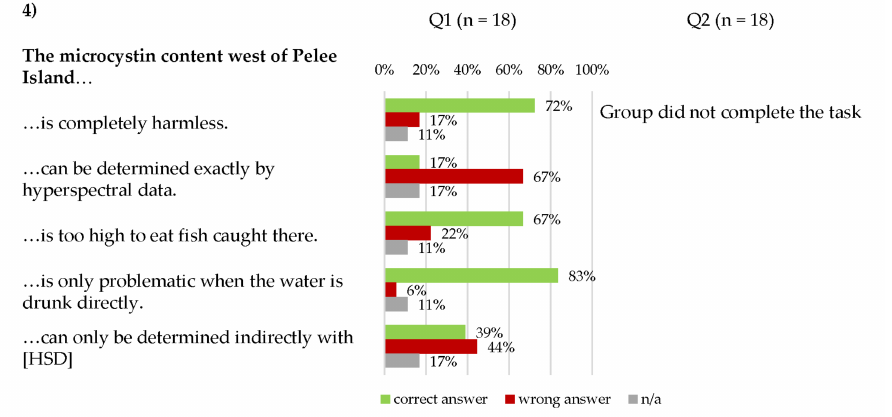
Figure 20. Answers from Q1 group to determine whether they understood the conclusive task that combines all knowledge gathered through the worksheet and